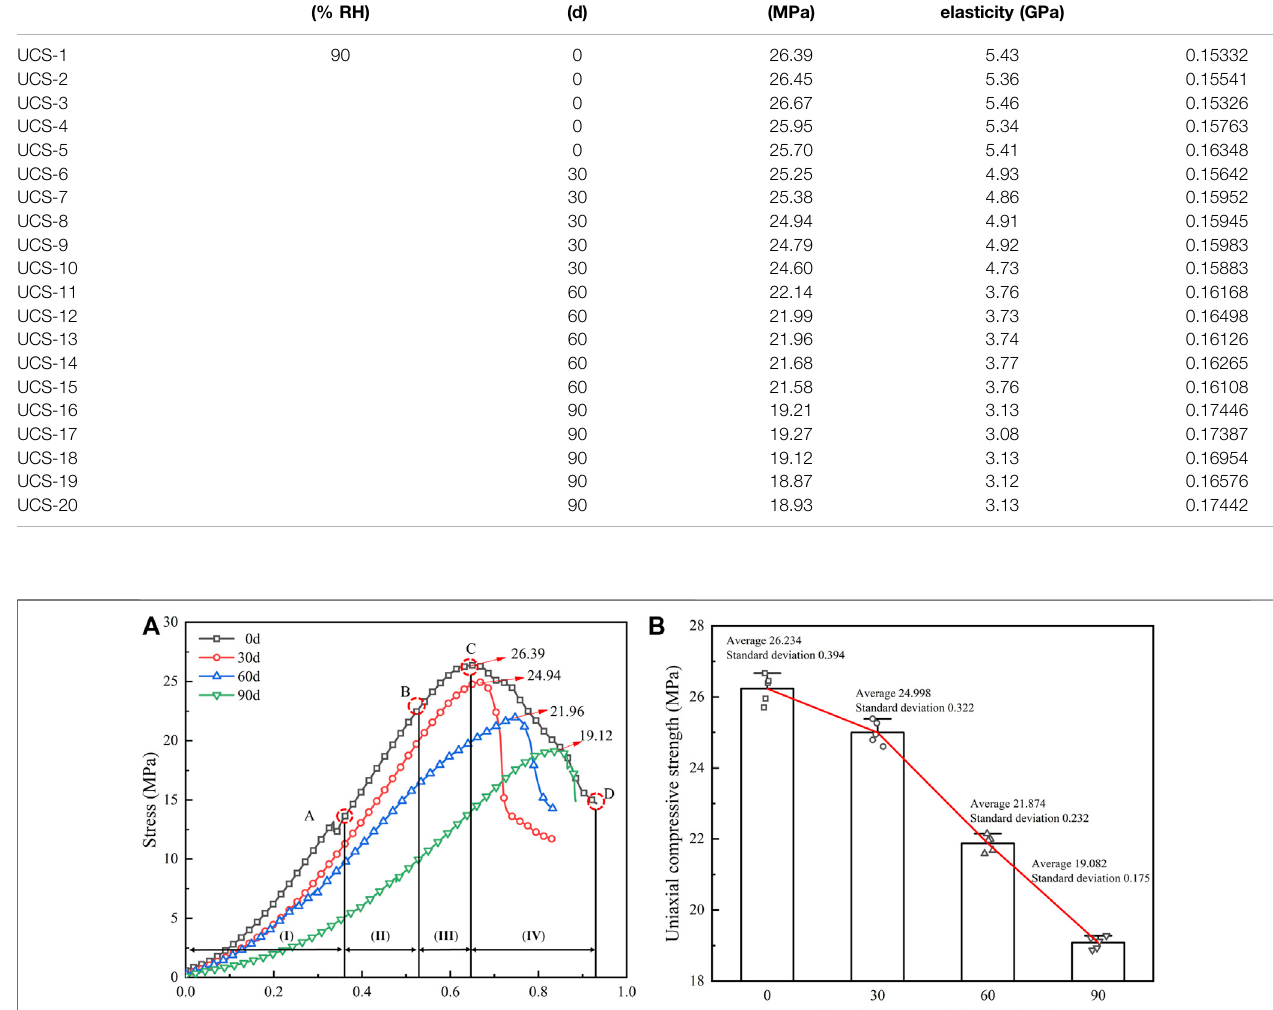
TABLE 2 | Uniaxial compression mechanic parameters of dolomite at each high-humidity action time node. Specimen number